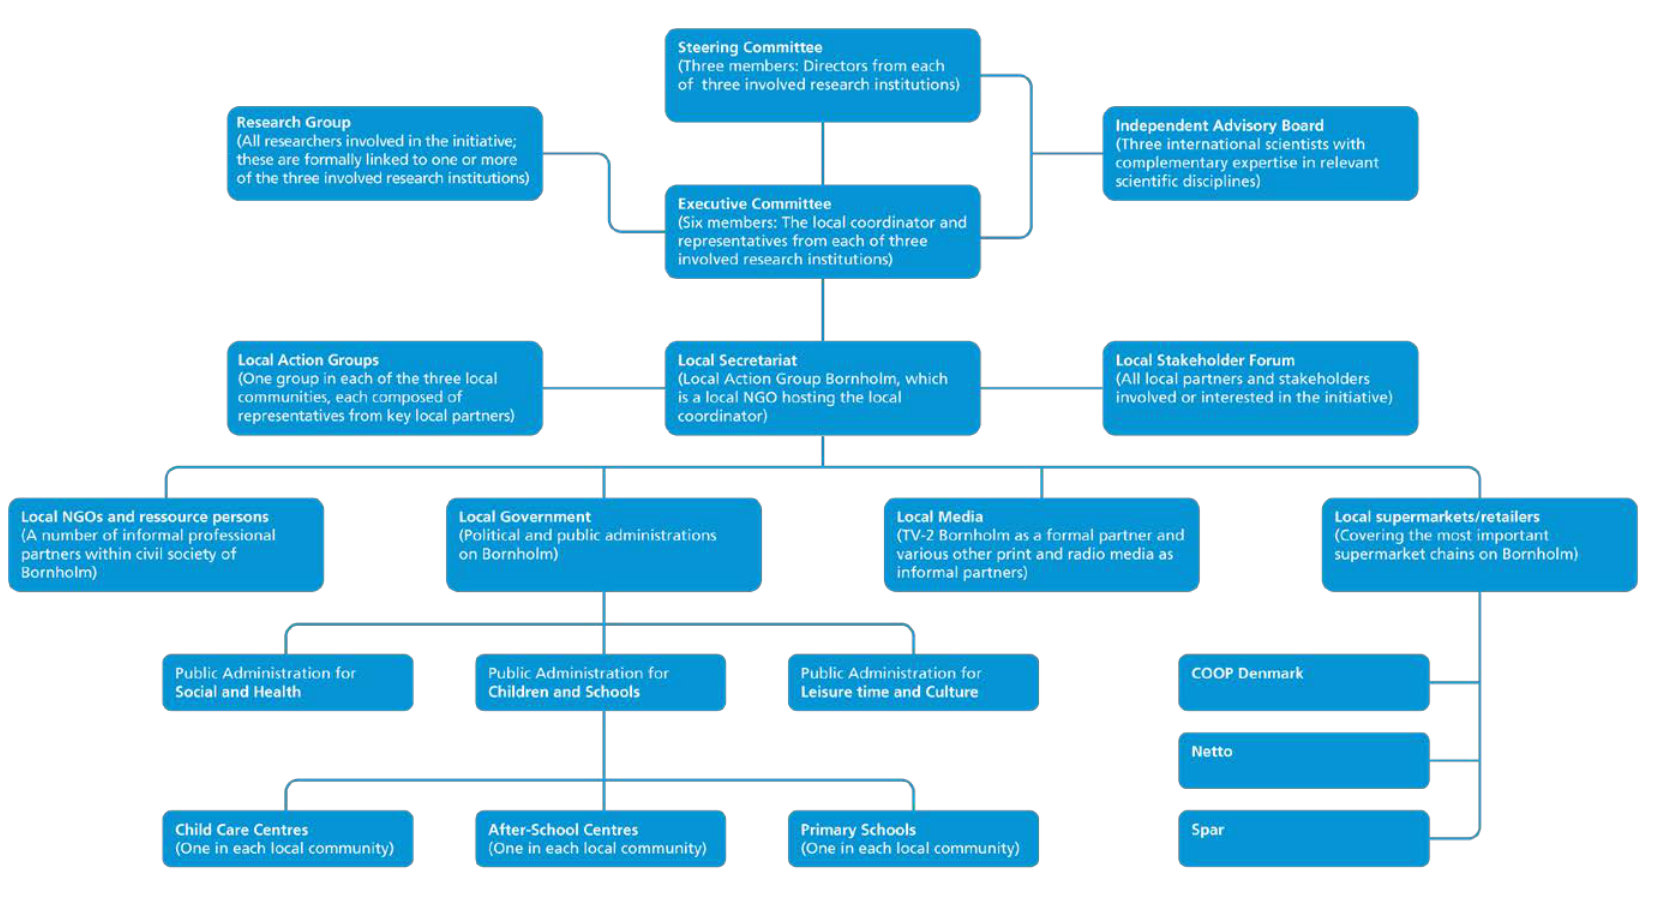
Figure 1. The organizational structure of Project SoL.